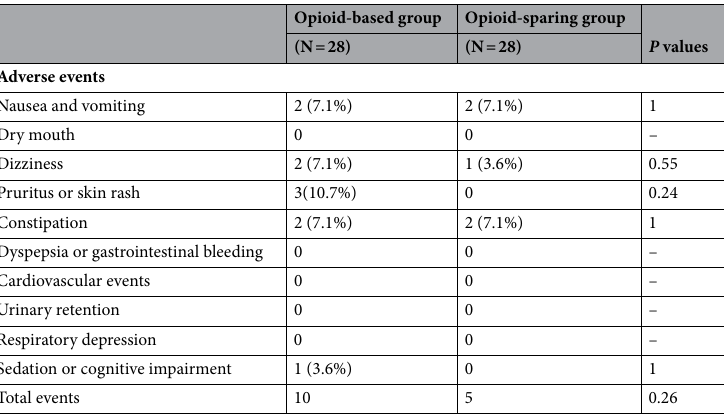
Table 3. Adverse events in both